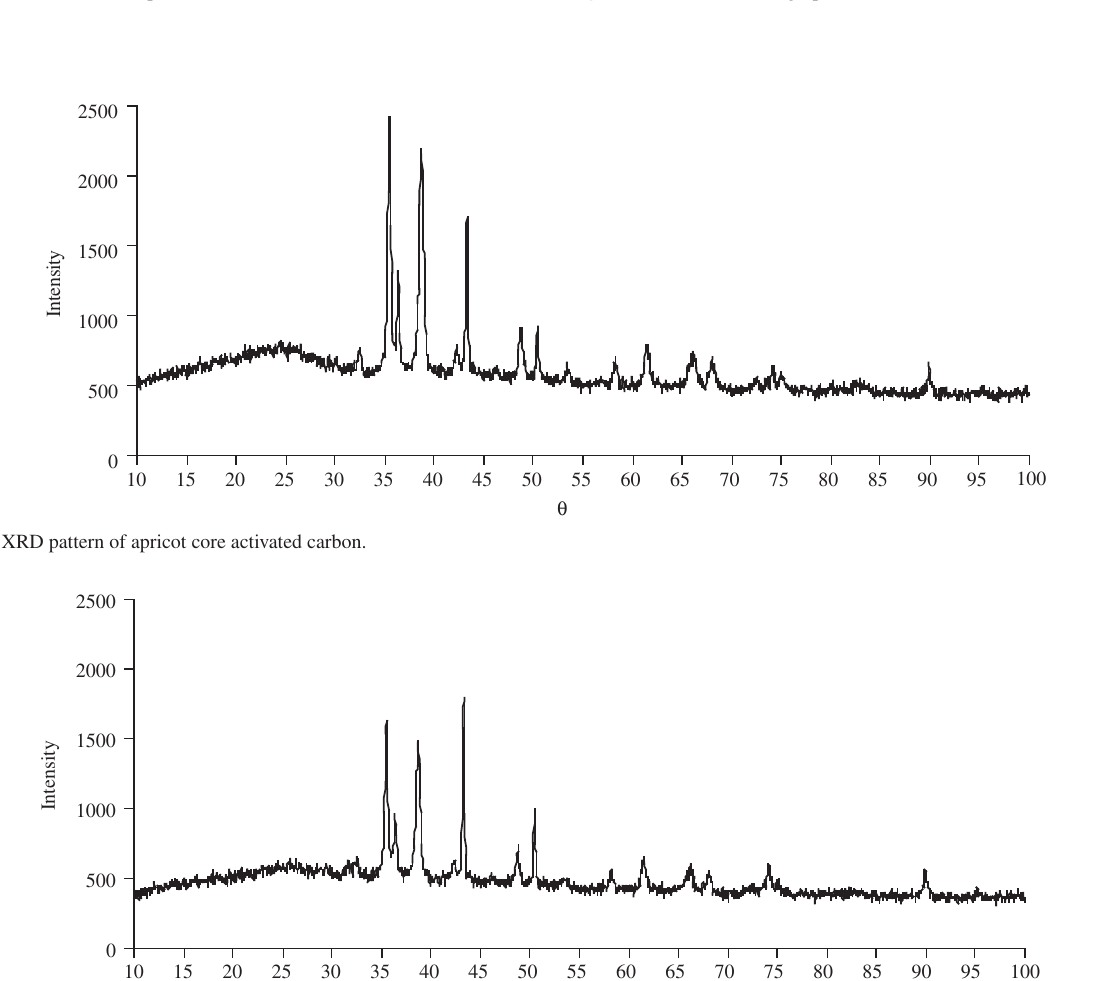
Figure 5. Mass titration of apricot core activated carbon. Figure 6. Mass titration of grape stalk activated carbon.